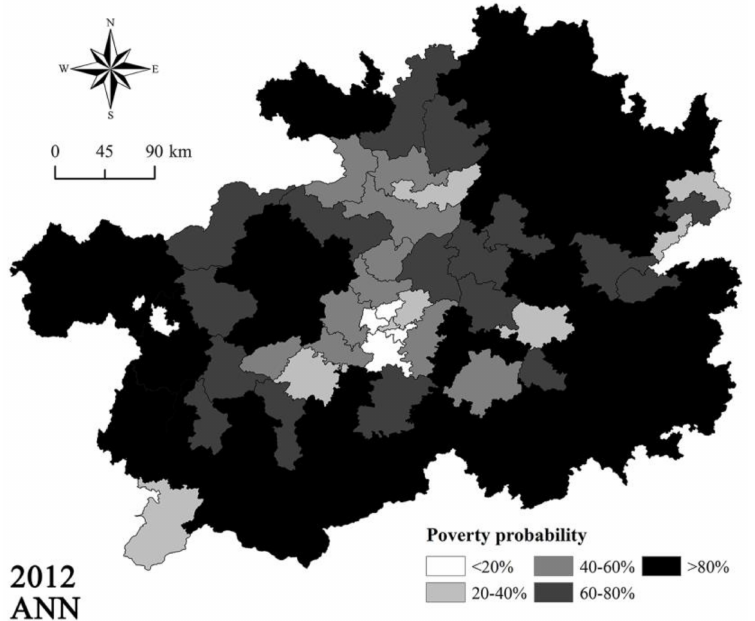
Figure 4. Distribution of poverty probability at the county level by the Artificial Neural Network (ANN) in